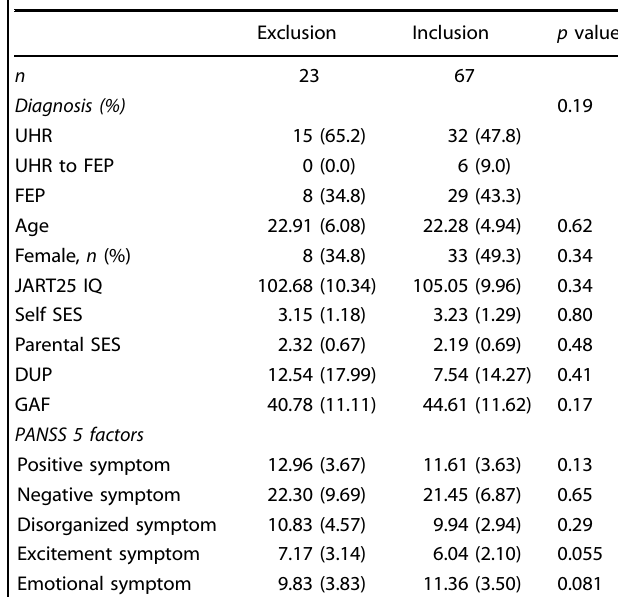
Fig. 1 Relationship between psychobiological characteristics and clinical outcomes. a The relationship between 13-month disorganized symptom and the surface area in the left orbital part of the inferior frontal gyrus (IFG-Orb) in the UHR group. b The relationship between the 28-month Social and Occupational Functioning Assessment Scale (SOFAS) score and the surface area in the left insula in the FEP group. Table 4. Demographic characteristics between those included and excluded in this